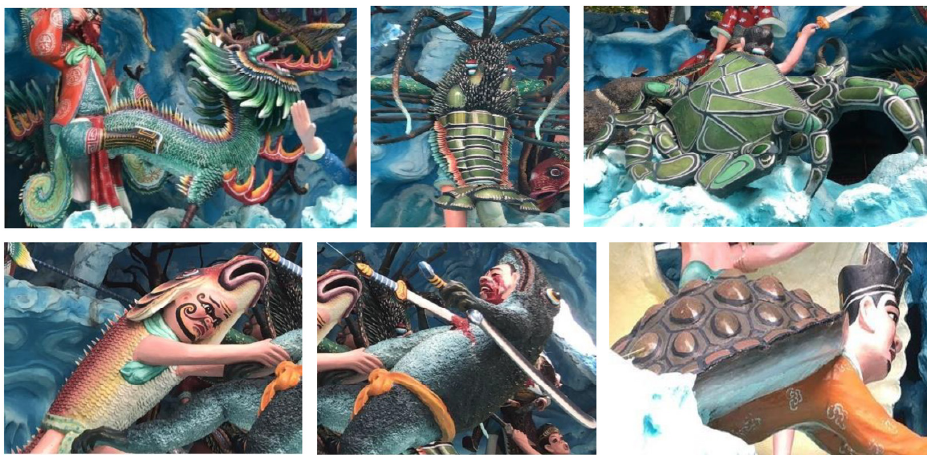
Figure 6. Dragon King, Shrimp Soldier, Crab General, and other monsters.